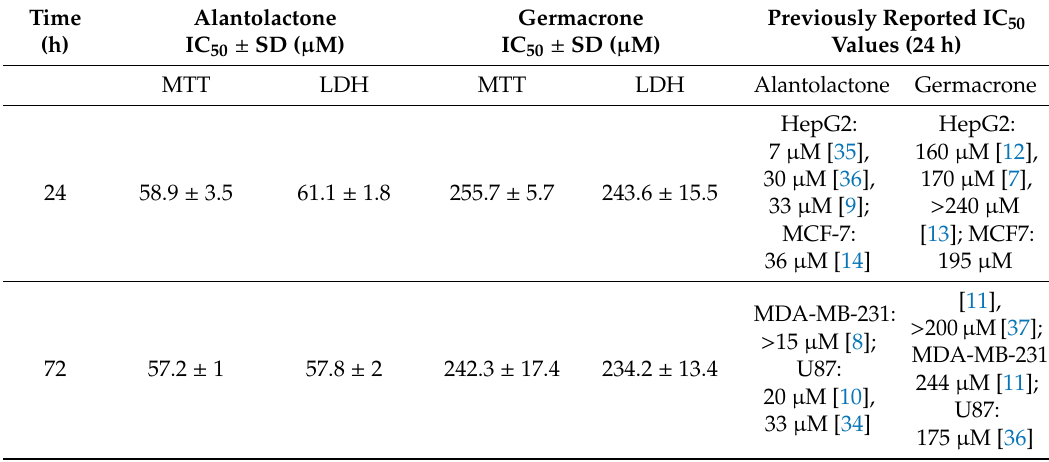
Table 1. Concentrations of ATL and GER ( µ M) resulting in 50% inhibition of dHepaRG cell viability (IC50) after 24 and 72-h single exposure, measured by MTT assay and lactate dehydrogenase (LDH) leakage. Examples of previously reported IC50 values for proliferative liver, breast, and glioblastoma cell lines are